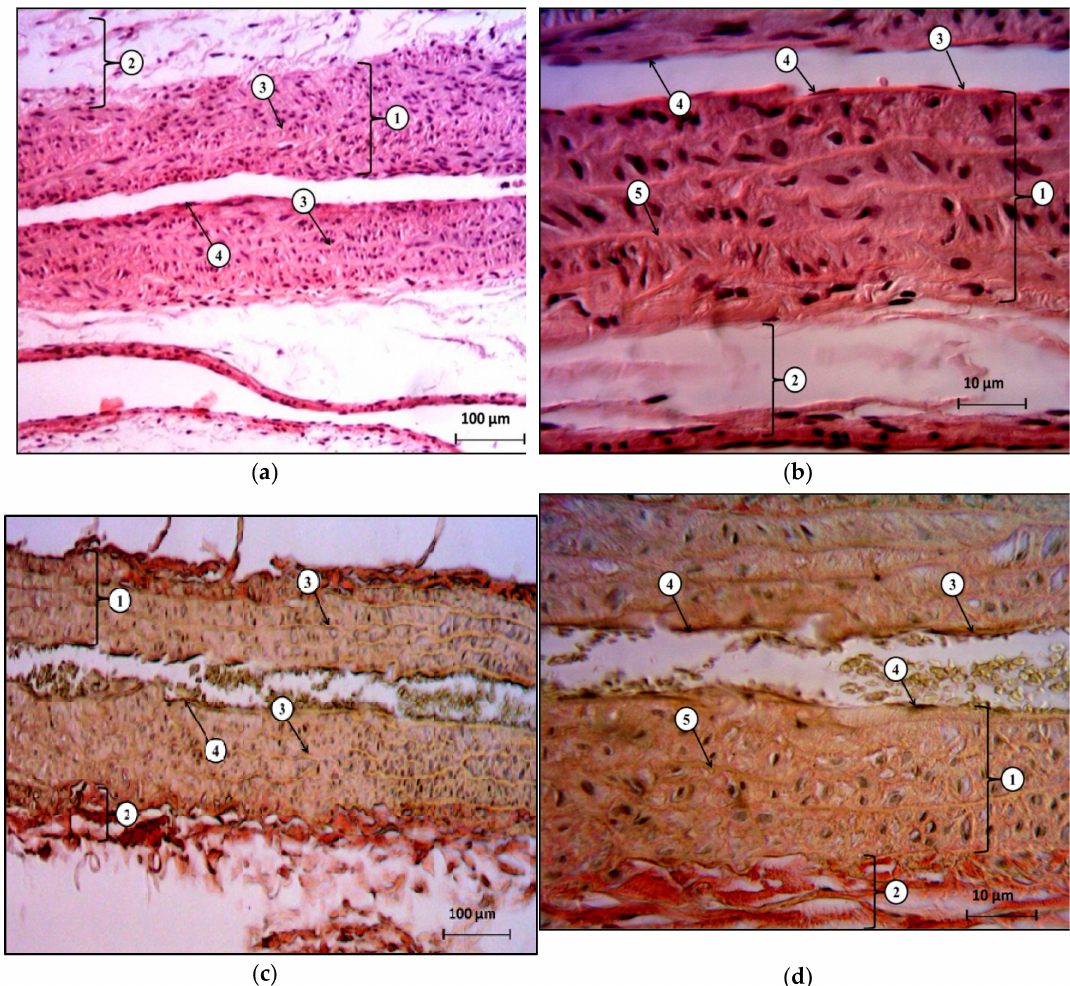
Figure 5. The histological structure of the abdominal aorta 43 days after bilateral ovariectomy in the group treated with 1 mg / kg DM-05: ( a )—stained with hematoxylin and eosin, x40; ( b )—stained with hematoxylin and eosin, x400; ( c )—stained by Van Gieson’s method, x40; ( d )—stained by Van